Question: Author a descriptive caption for the visualization shown.
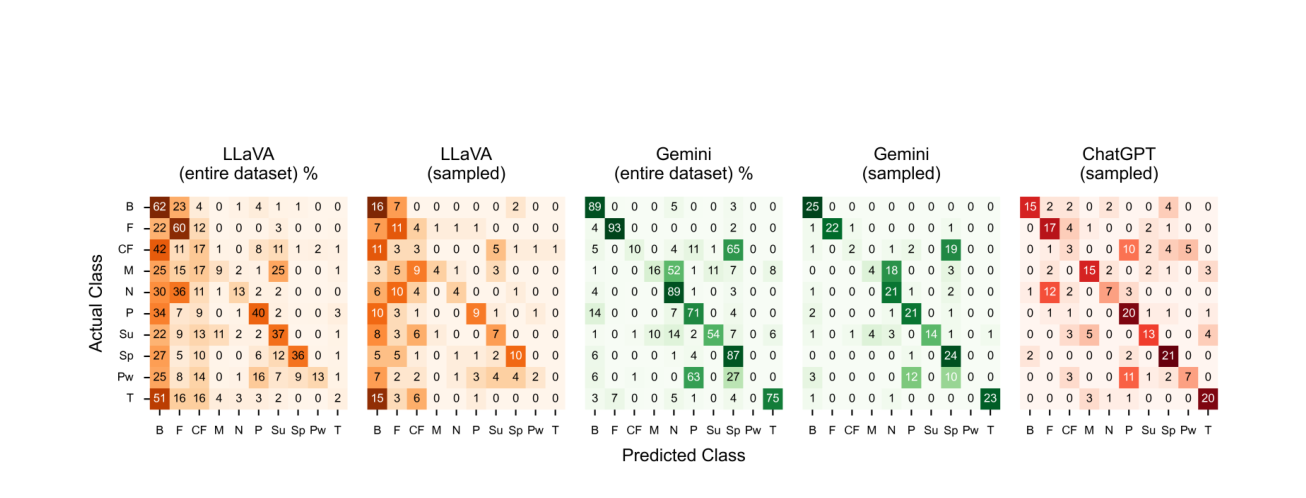
Answer: Confusion matrices for the classification of ten categories in the NFFA dataset by (a) LLaVA on the entire dataset (numbers denote percentages with respect to the number of actual samples present in the respective classes), (b) LLaVA on 25 images per class of the NFFA-RS, (c) Gemini on the entire dataset (numbers denote percentages as in (a)), (d) Gemini on 25 images per class of the NFFA-RS, and (e) ChatGPT on 25 images per class of the NFFA-RS. Class names have been abbreviated as noted in Table I.